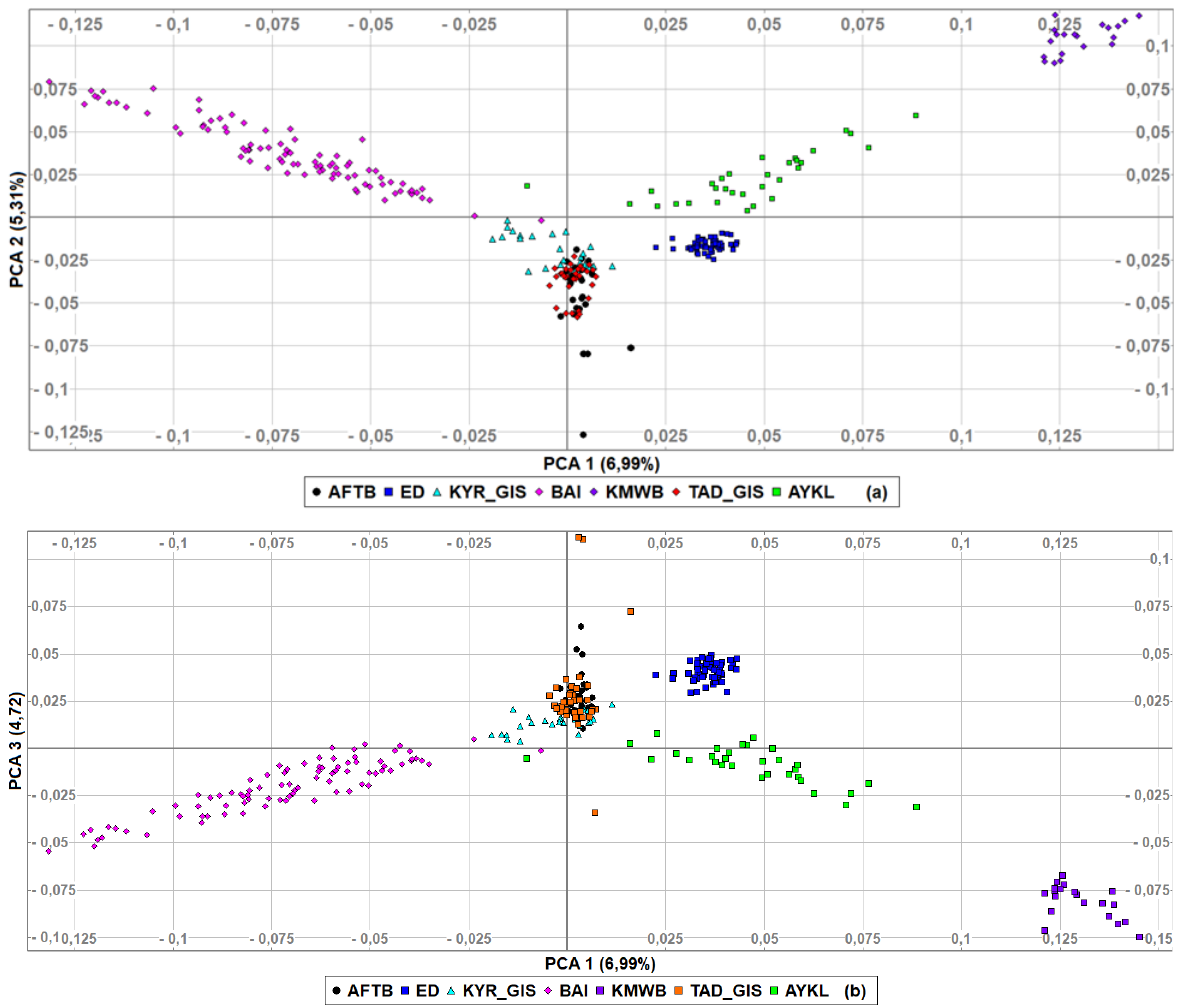
Figure 3. Principal components analysis of the studied sheep populations ( a ) PCA1 and PCA2, ( b ) PCA1 and PCA3. Afghan fat-tailed breed (AFTB), Aykol (AYKL), Edilbay (ED), KYR_GIS (Gissar breed — imported from Kyrgyzstan), Baisary (BAI), Kazakh meat-wool breed (KMWB), TAD_GIS (Gissar breed — imported from Tajikistan).